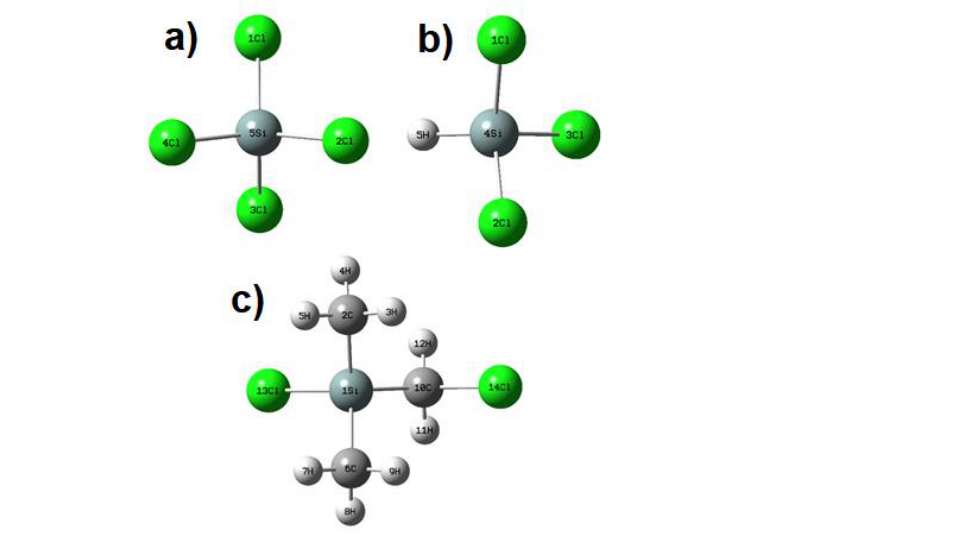
Figure 1. Structures of all investigated chlorinated silanes: ( a ) tetrachlorosilane, ( b ) trichlorosilane, ( c ) chloro(chloromethyl)dimethylsilane.